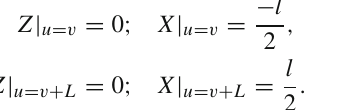
Fig. 8 W R ( t ) in terms of boundary time t for k = 0 . 3 and l = 1. For the left panel μ f = 0 . 0220, T f = 0 . 2200 and for the right panel μ f = 0 . 8475, T f = 0. The static potential is V ( l ) = − 0 . 1017 ( − 0 . 1793)